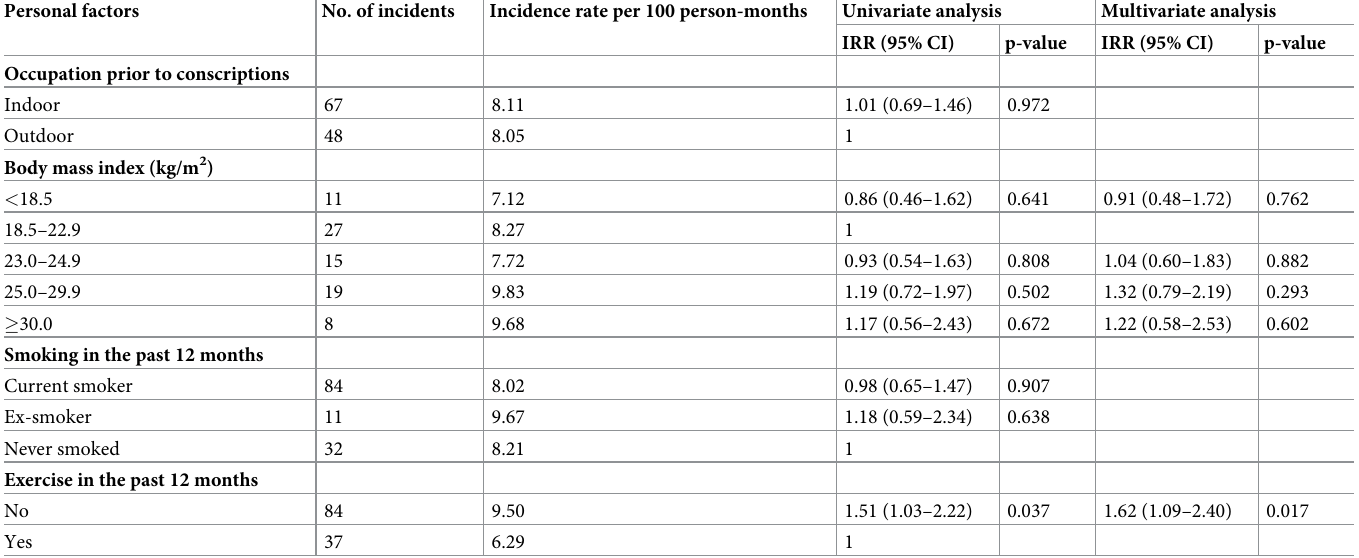
Table 4. Personal risk factors associated with a tympanic temperature greater than 37.5˚C among new conscripts during basic military training. Personal